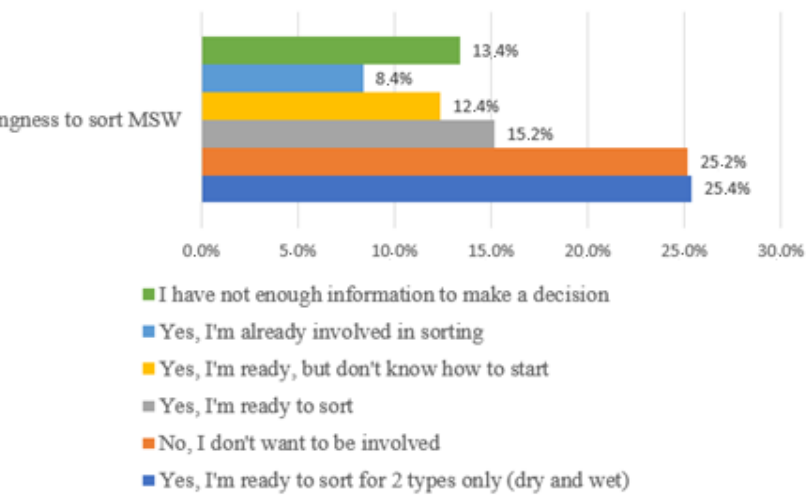
Figure 2. Attitude of Russian people towards participation in separate MSW collection.